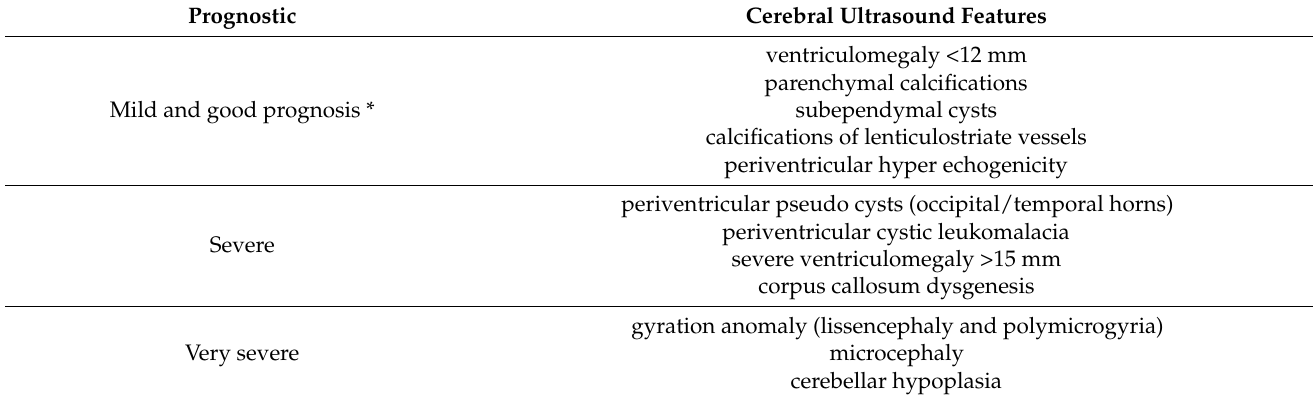
Table 3. Classification of prenatal cerebral ultrasound abnormalities, adapted from